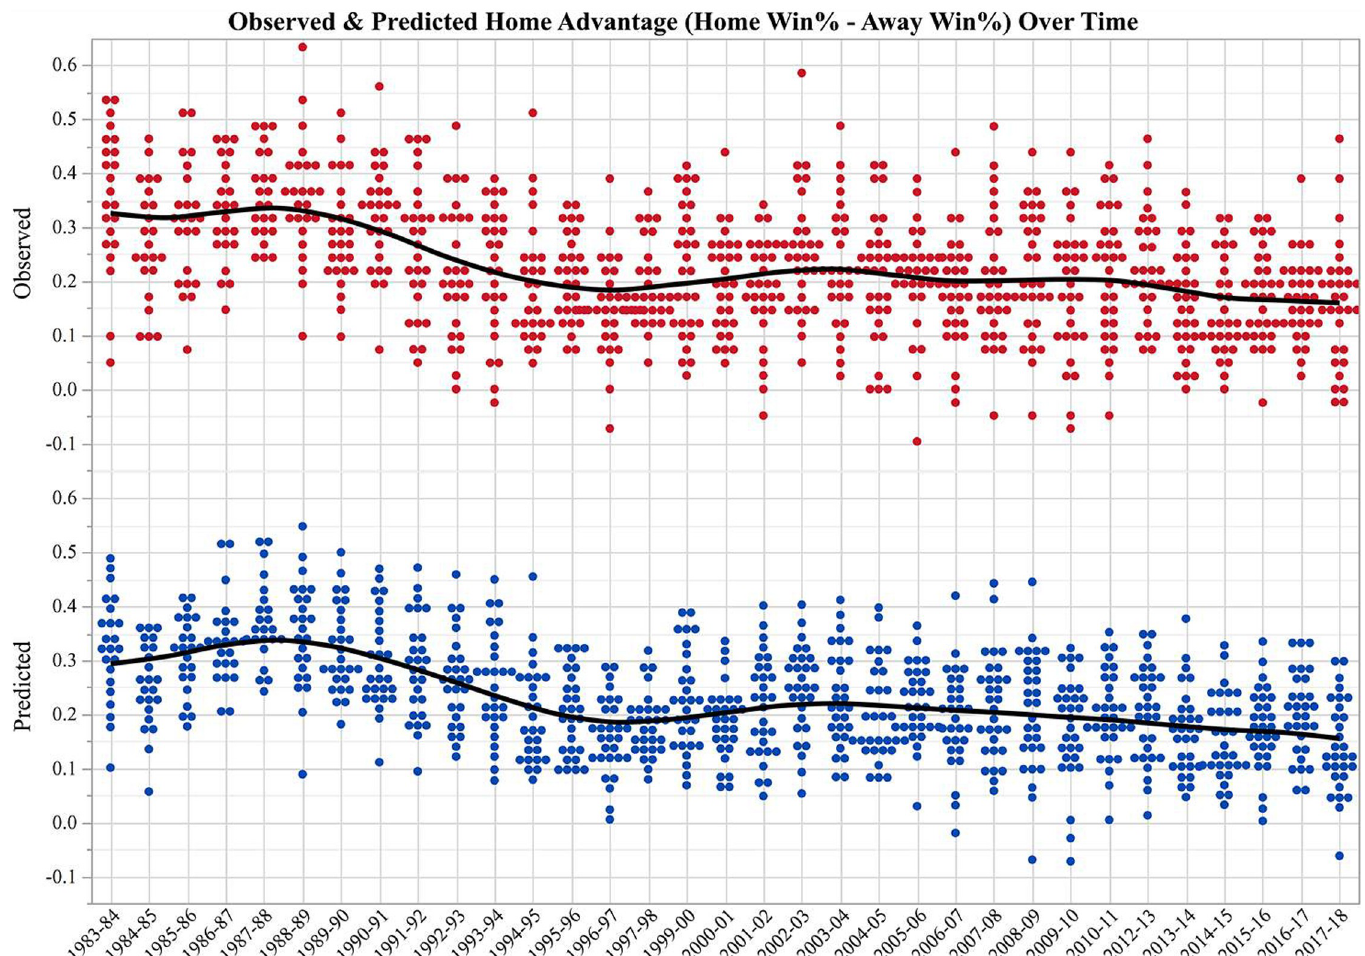
Fig 2. Predicted and observed home advantage over time. Observed (red) and diagnosed (blue) home advantage with a best fit line